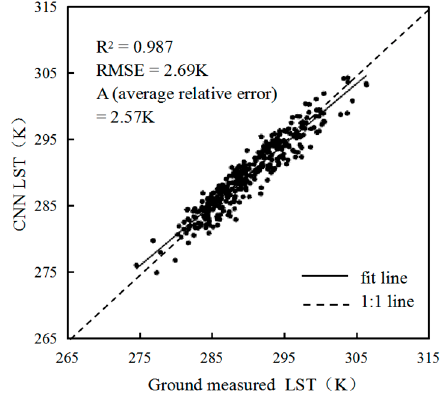
Figure 7. Scatterplot of CNN retrieval results and ground-measured data.